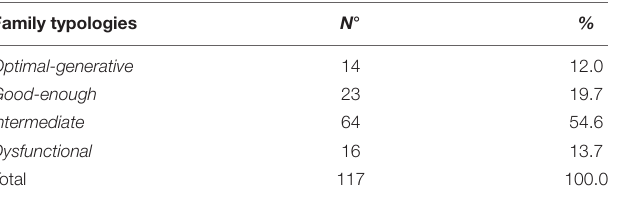
TABLE 6 | Frequency distribution of the first family typologies emerged. Family